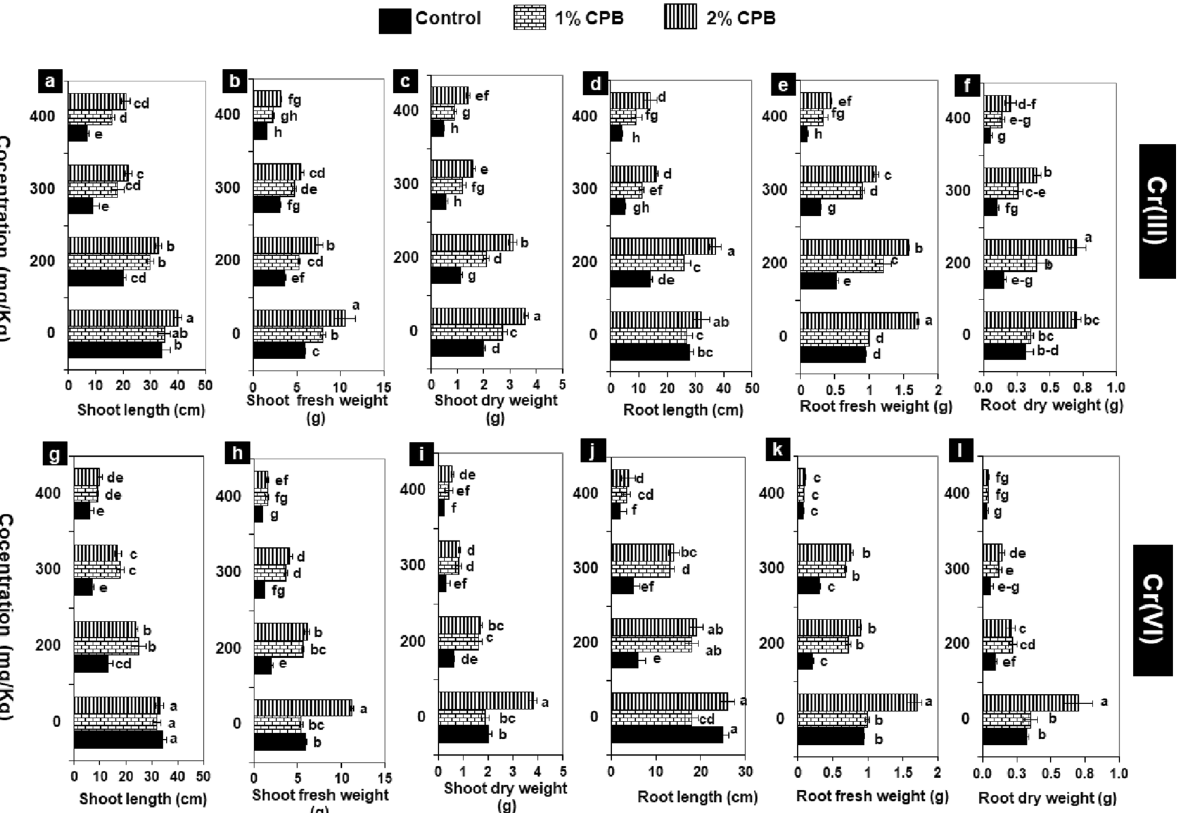
Figure 4. ( a – l ) Effect of soil amendment with plant biomass of Cloncurry buffel grass (CPB) on growth attributes of 60-day old tomato plant under Cr(III) and Cr(VI). Vertical bars show standard errors of the means of three replicates. Values with different letters at their top show a significant difference (p ≤ 0.05) as determined by the LSD